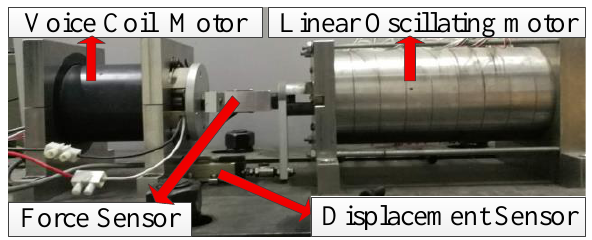
Figure 10. Image of linear oscillating load system.